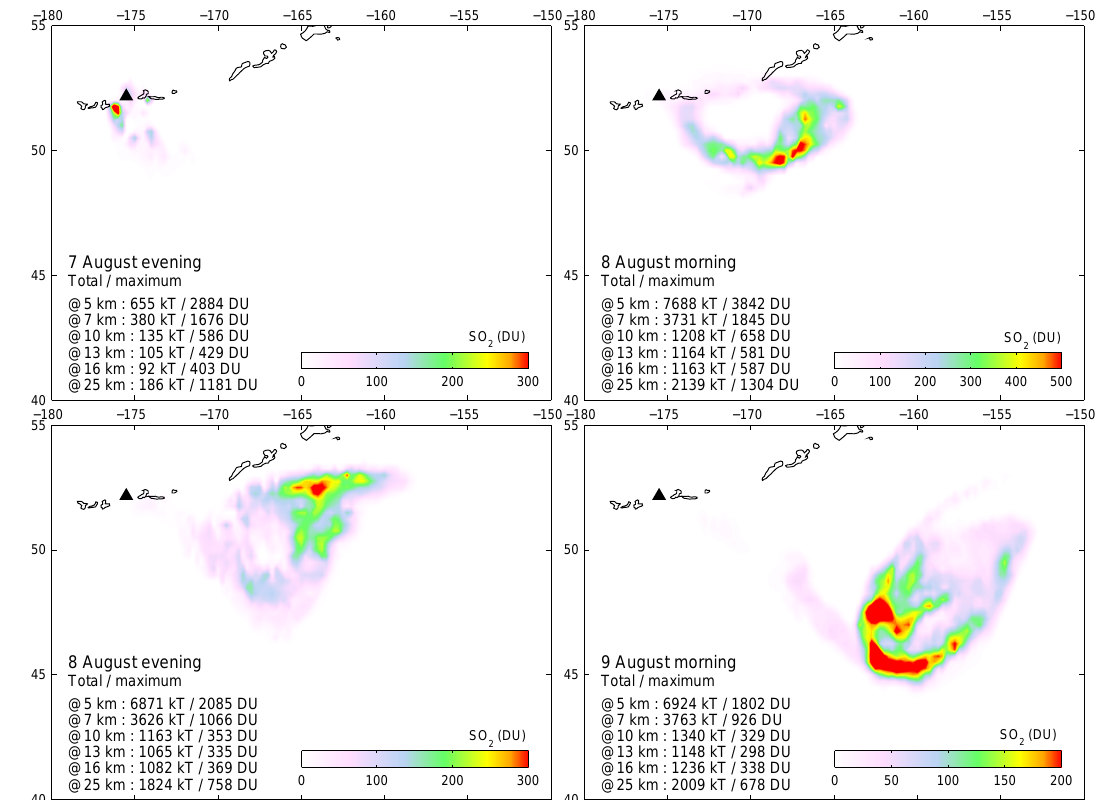
Fig. 9. The eruption of Kasatochi (Aleutian islands) on 7 and 8 August as seen by IASI, with a 5–20km altitude SO 2 plume drifting to North America. For the displayed columns an altitude of 10km was